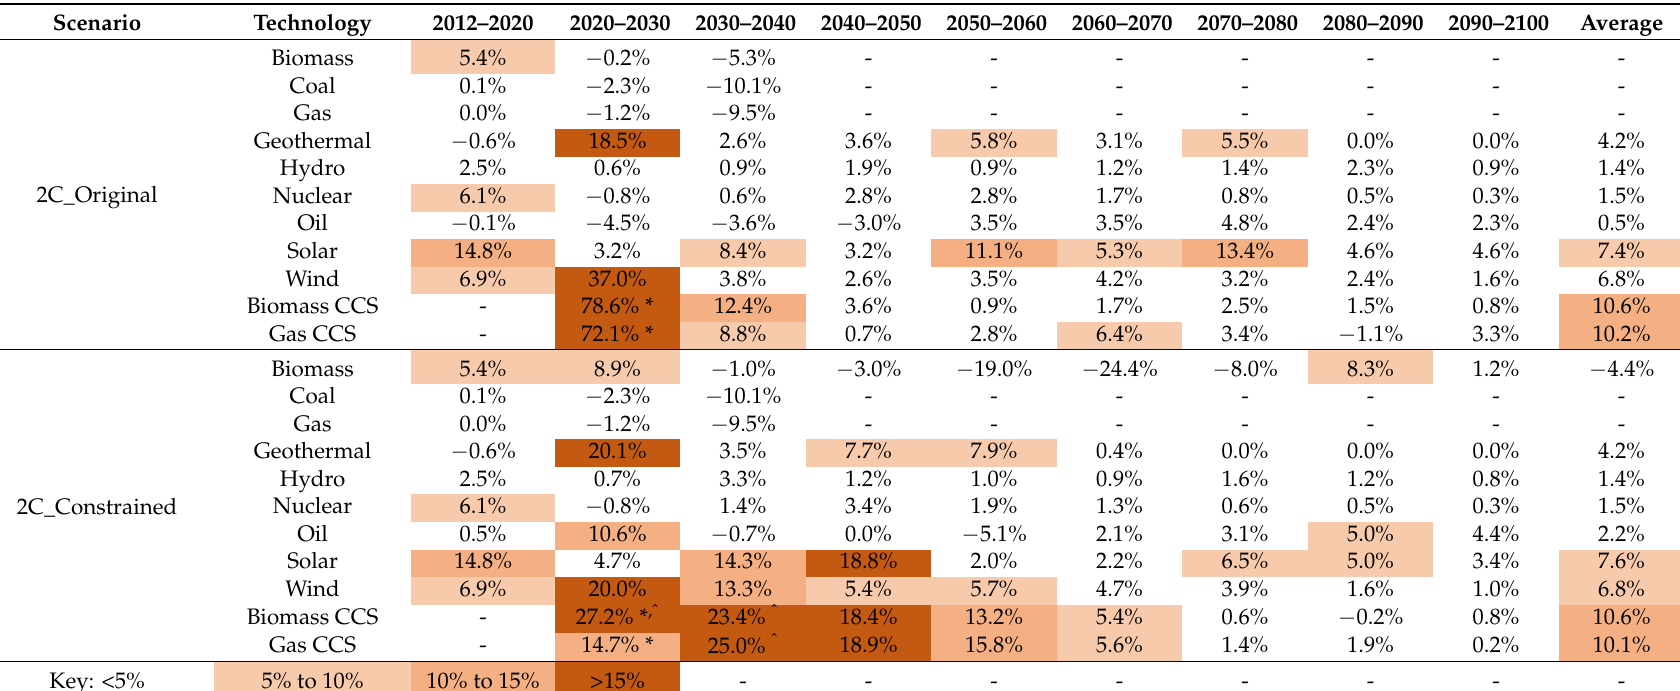
Table 6. Average annual growth rates by decade for the 2C_Original and 2C_Constrained